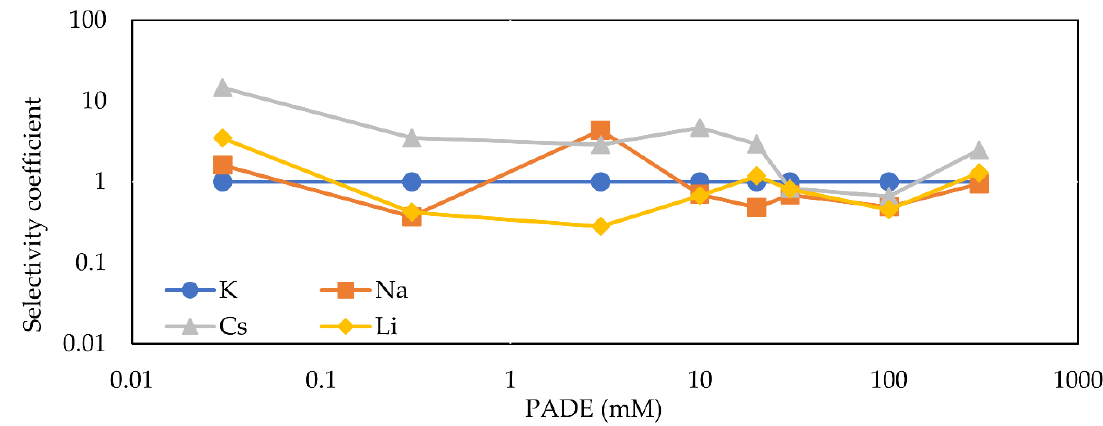
Figure 8. Variation of the selectivity coefficient ( 𝑘 (cid:3012),(cid:3037)(cid:3043)(cid:3042)(cid:3047) ) with different PADE concentrations.